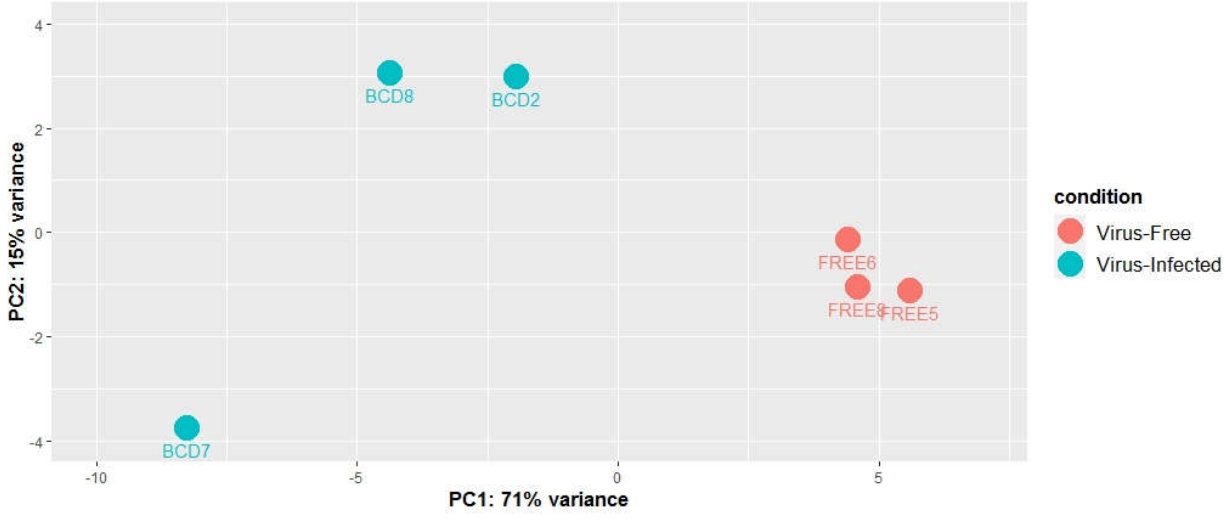
Figure 2. Principal components analysis (PCA) model built on the normalized counts of 3272 small RNA loci of three virus-infected fungal cultures (BCD) and three virus-free fungal cultures (FREE). The fold change (FC) of normalized expression of BCD samples to normalized ex- pression of FREE samples was calculated for each major small RNA of the 3272 small RNA loci. We used a FC cut off of 1.5 (log2(FC) = ±0.6). Adjusted p -values (padj) were used with a threshold at 0.05 to identify statistically significant differences in expression. Small RNAs were classified into three groups: (1) upwardly expressed small RNAs: log2(FC) ≥0.6; (2) equally expressed small RNAs: − 0.6< log2(FC) <0.6; (3) downwardly expressed